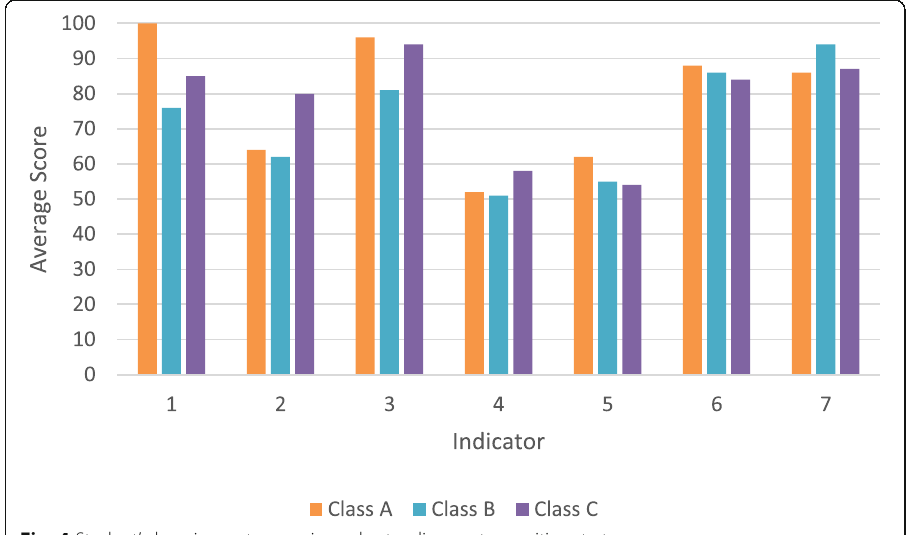
Fig. 4 Student ’ s learning outcomes in understanding metacognitive